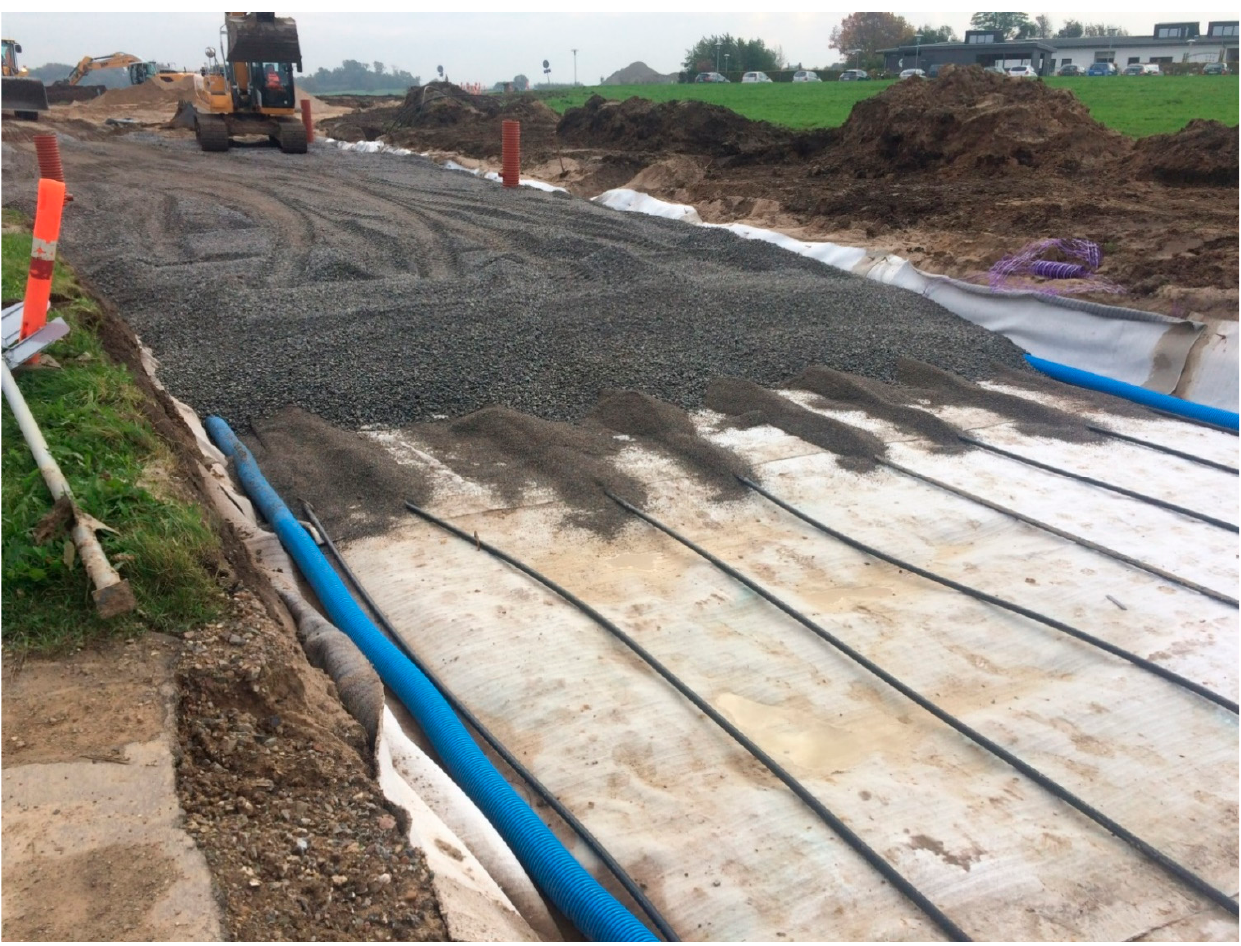
Figure 2. The construction pit with the bentonite membrane (white geotextile), blue Ø160 mm drainage pipes on the sides, and black geothermal piping loops embedded in soft DrænAF gravel with the coarser DrænStabil gravel on top. The kindergarten with the GSHP using the Climate Road as a collector is visible in the top right corner of the picture.